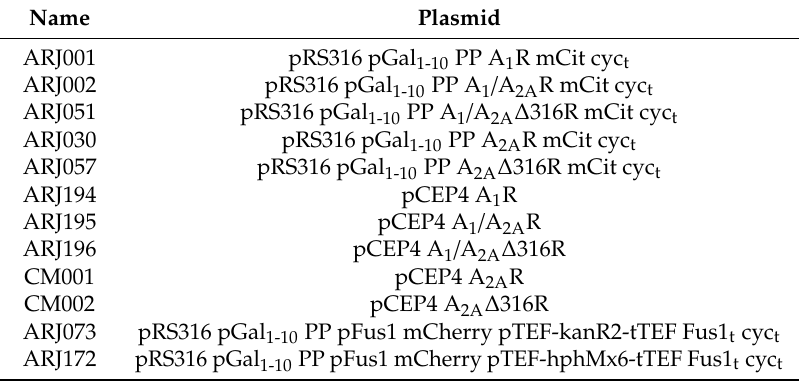
Table 3. List of plasmids used for receptor expression in yeast and mammalian cells. Yeast expression plasmids contain an N-terminal leader sequence (PP) to improve receptor expression and tra ffi cking to the plasma membrane